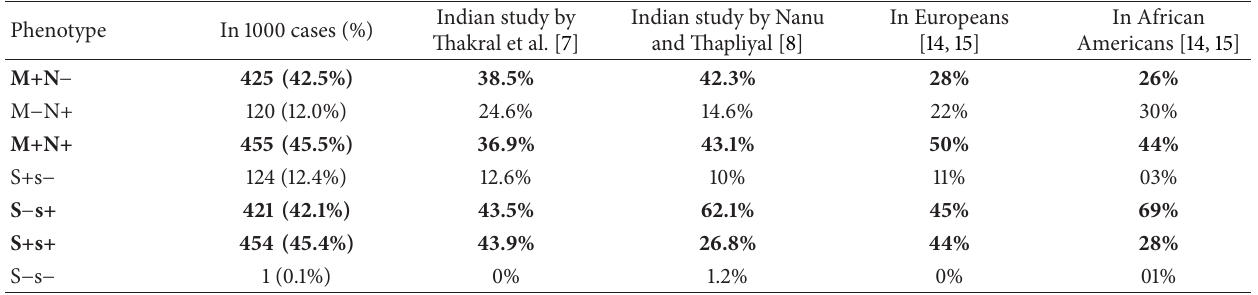
Table 5: Phenotype frequencies of MN and Ss in MNS blood group